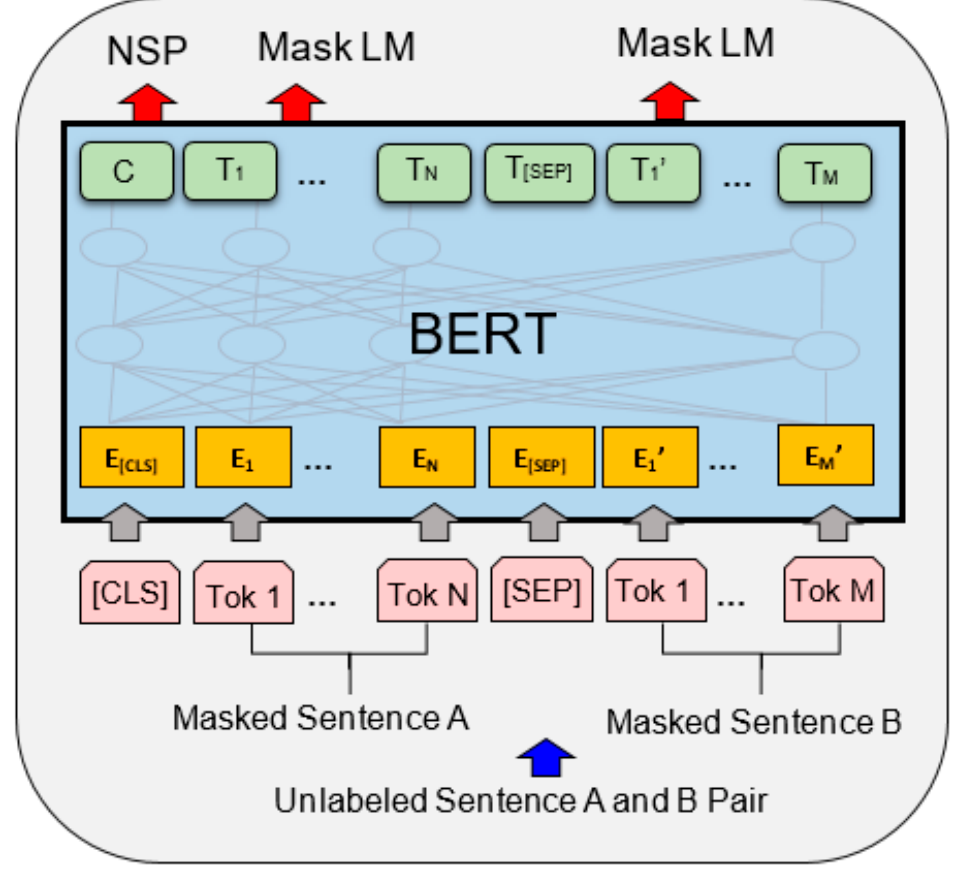
Figure 26. BERT-Pre training [69].